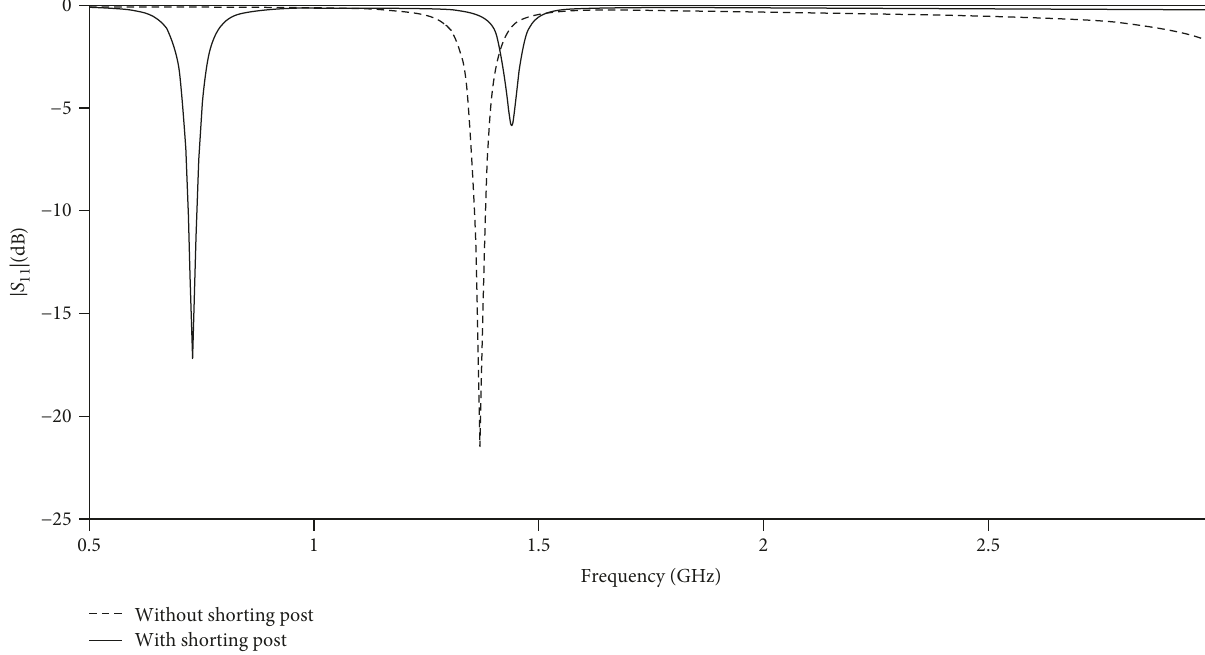
Figure 4: Simulation results for the re fl ection coe ffi cient of Koch fractal antenna of level k = 2 , without and with the shorting post.